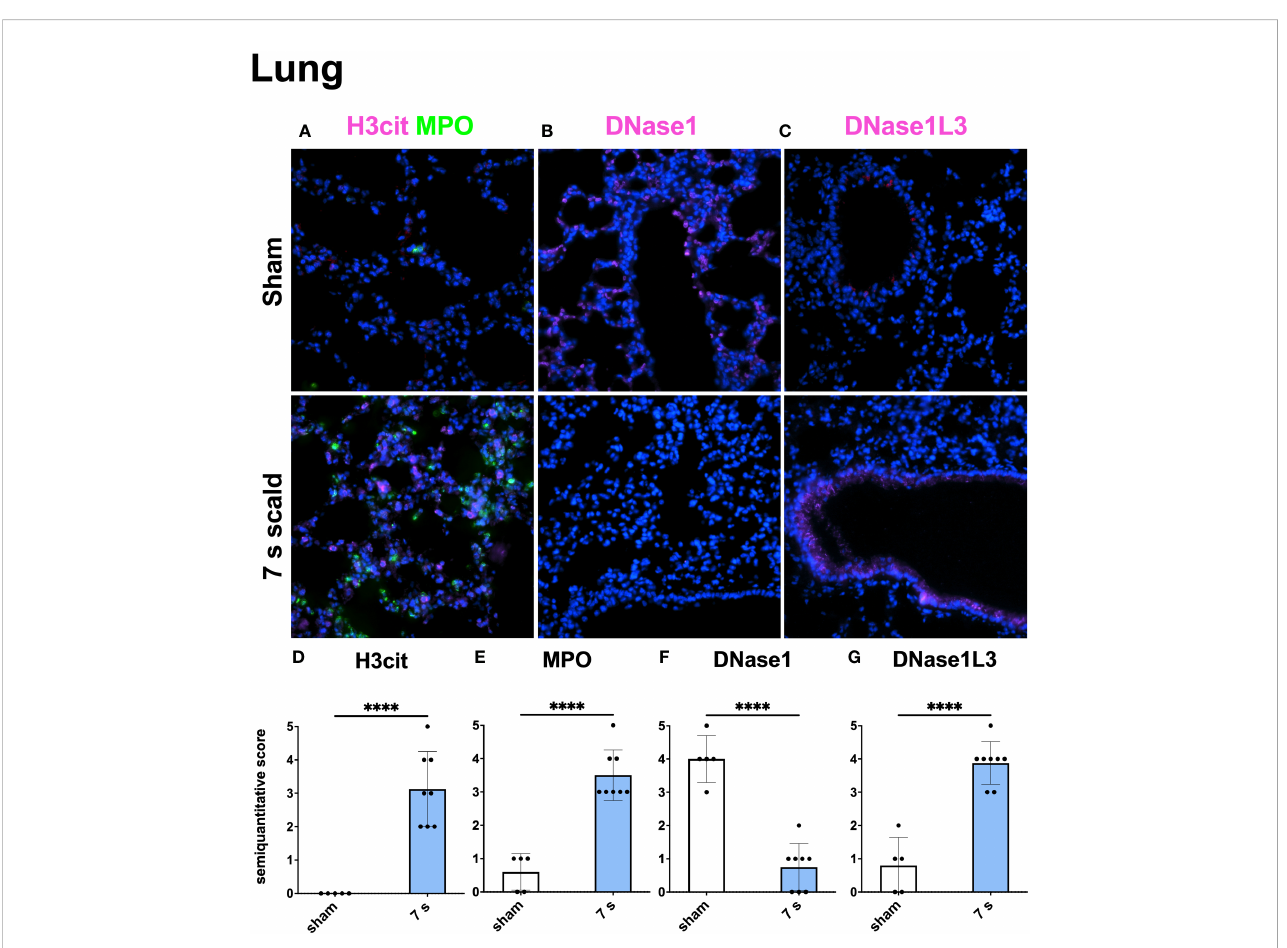
FIGURE 12 The immuno fl uorescence staining of the lung shows a massive NET formation and a down- or upregulation of DNase1 and DNase1L3, respectively. Representative merge images of immuno fl uorescence staining of the lung for H3cit/MPO (A) , DNase1 (B) , and DNase1L3 (C) are displayed. DNA counterstain was performed with DAPI (blue). Magni fi cation level 40x. Note the inverse reaction of DNase1 and DNase1L3. Semiquantitative scores were used to estimate the amount of H3cit (D) , MPO (E) , DNase1 (F) , and DNase1L3 (G) . Results are provided as mean ± SD. For comparison, an unpaired t -test was performed. The level of signi fi cance: ****p <